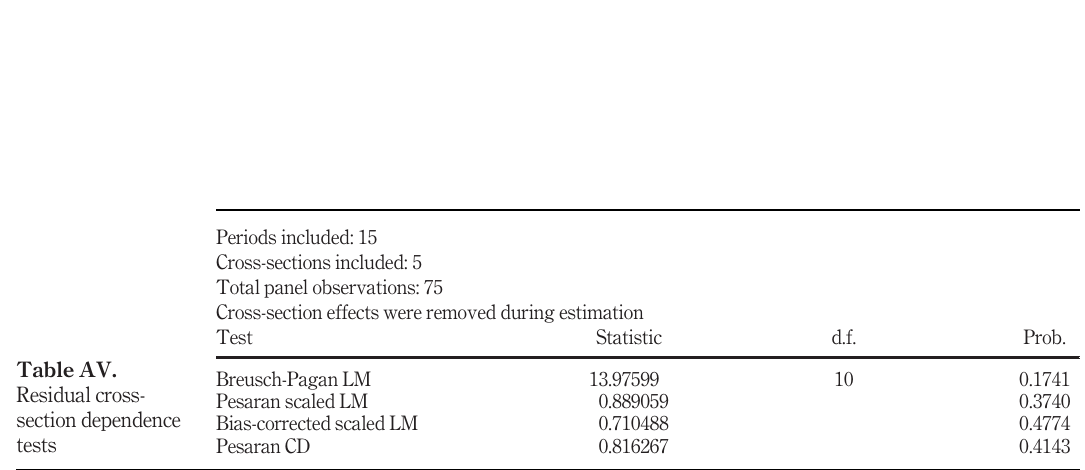
Table AIV. Correlated random effects – Hausman